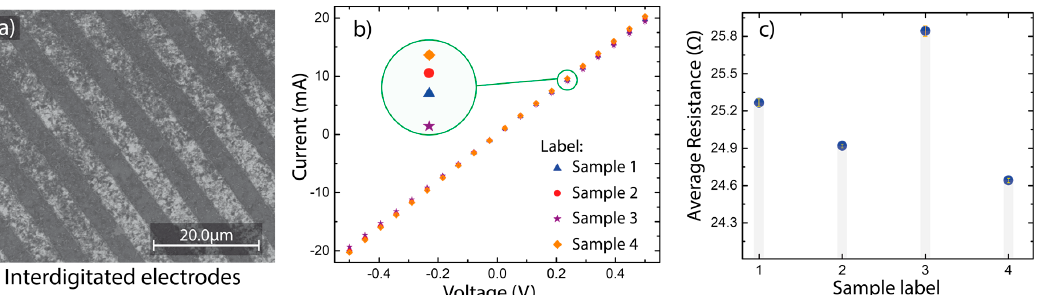
Figure 4. Electrical characterization. ( a ) SEM image of the obtained FLG dispersion on an interdigitated gold electrode prepared by drop casting of dispersion (2 𝜇 L). ( b ) I-V measurements of four prepared samples. ( c ) Average resistance measured on the four prepared samples. Five measurement cycles are realized at each sample in order to acquire a reliable statistic. The gap between the electrodes is ~5 𝜇 m.